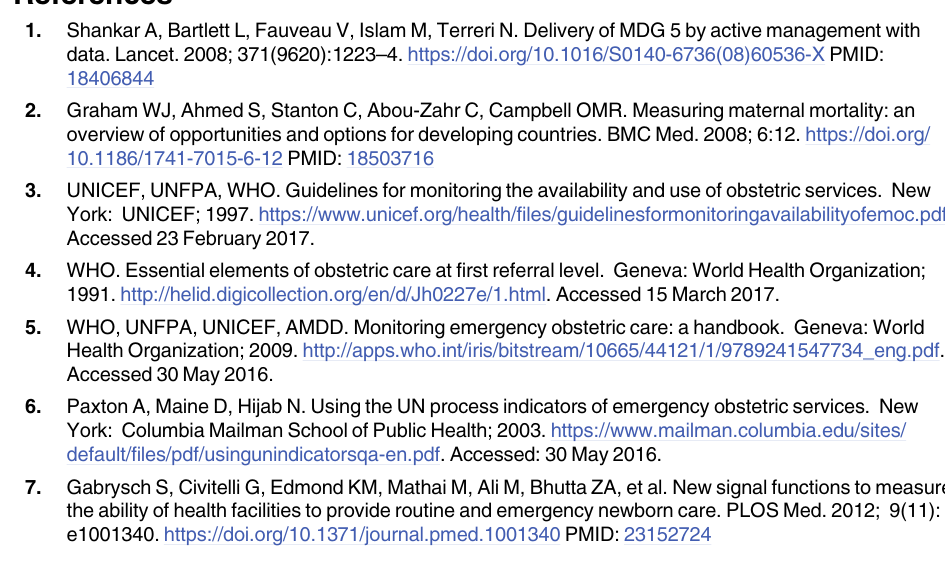
S1 Table. A comparison of the traditional weighting method versus the delivery caseload method for assessing facility